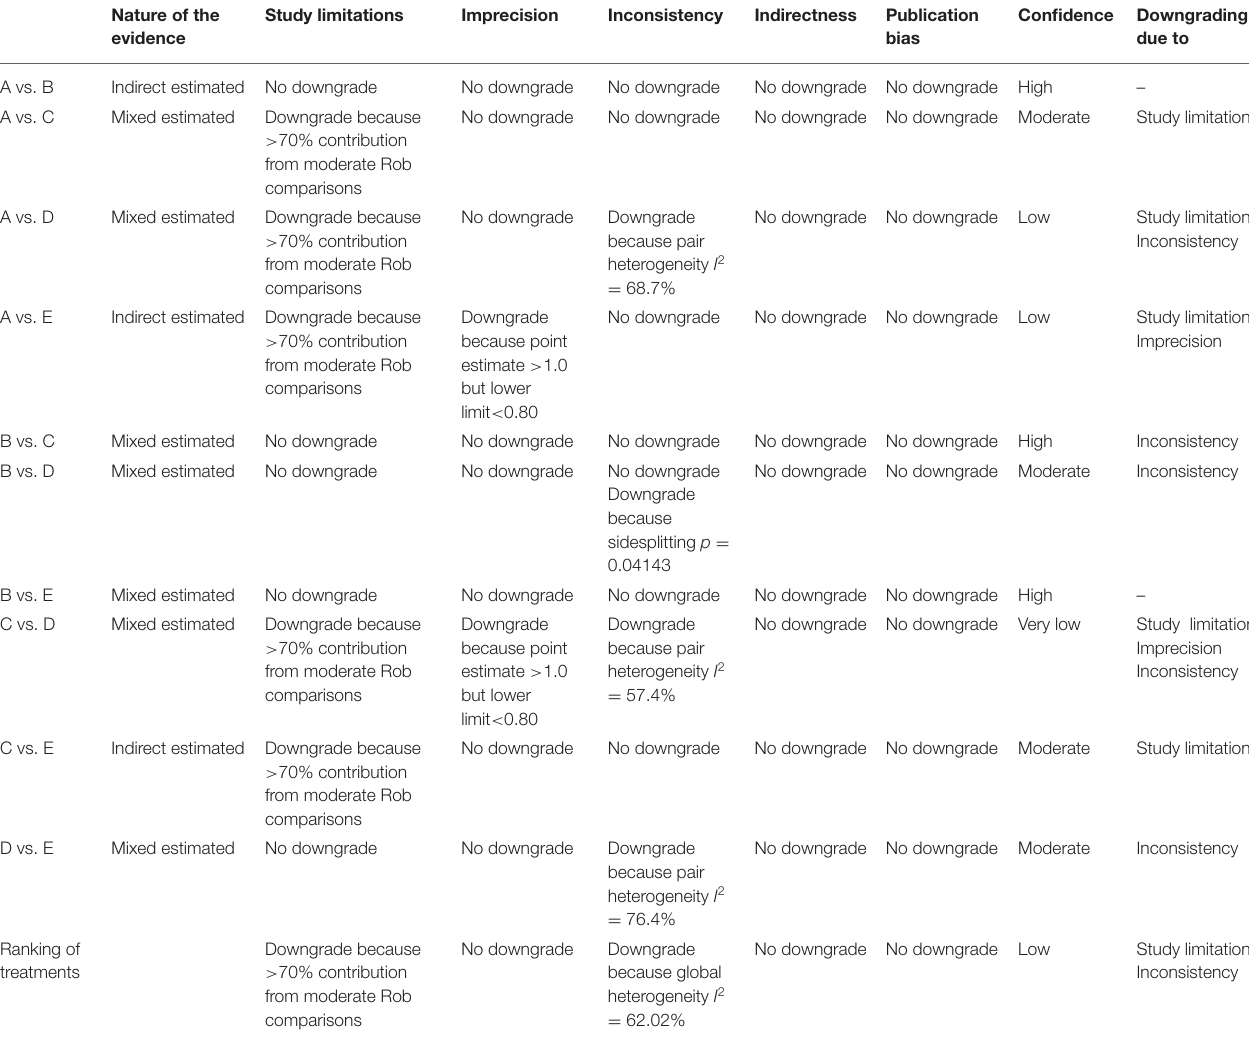
TABLE 6 | Result of GRADE for nosocomial